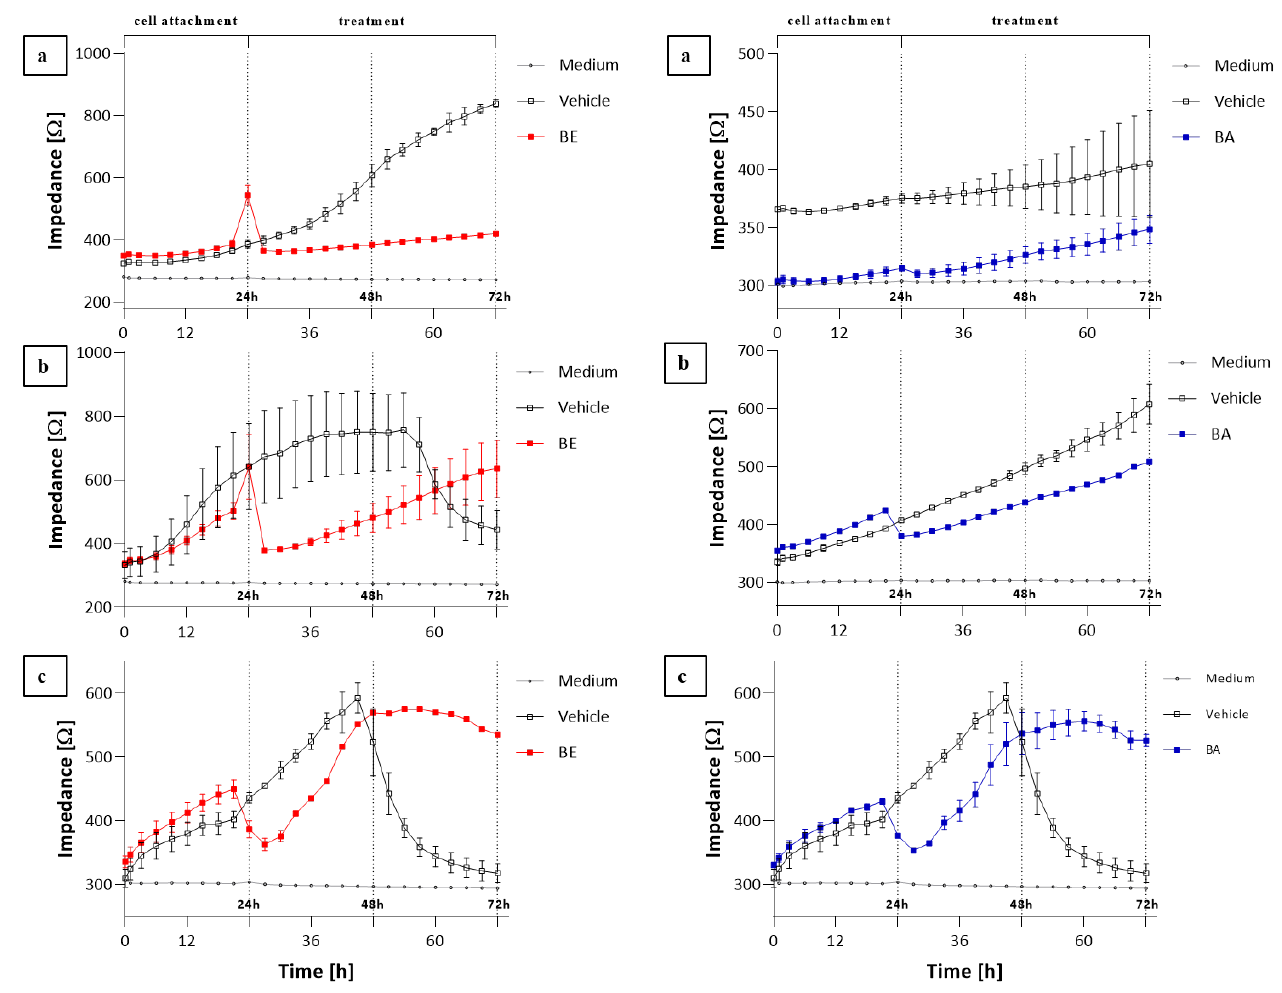
Figure 3. Impedance changes monitoring of the cell line ( a ) A549, ( b ) T47D, ( c ) Vero during 48 h treatment with BE (red line) and BA (blue line). Data are presented as mean value ± SEM.